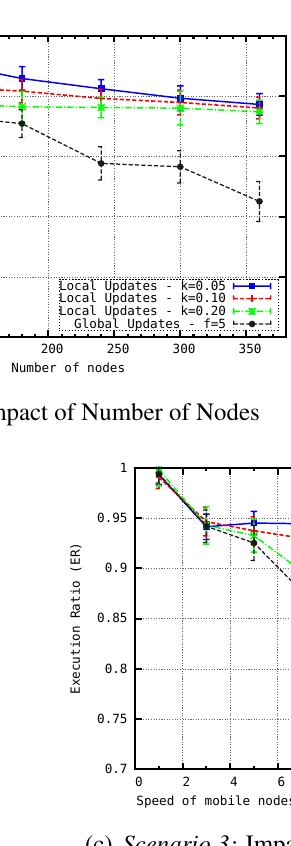
Figure 13. Comparison of local and global updates in terms of Execution